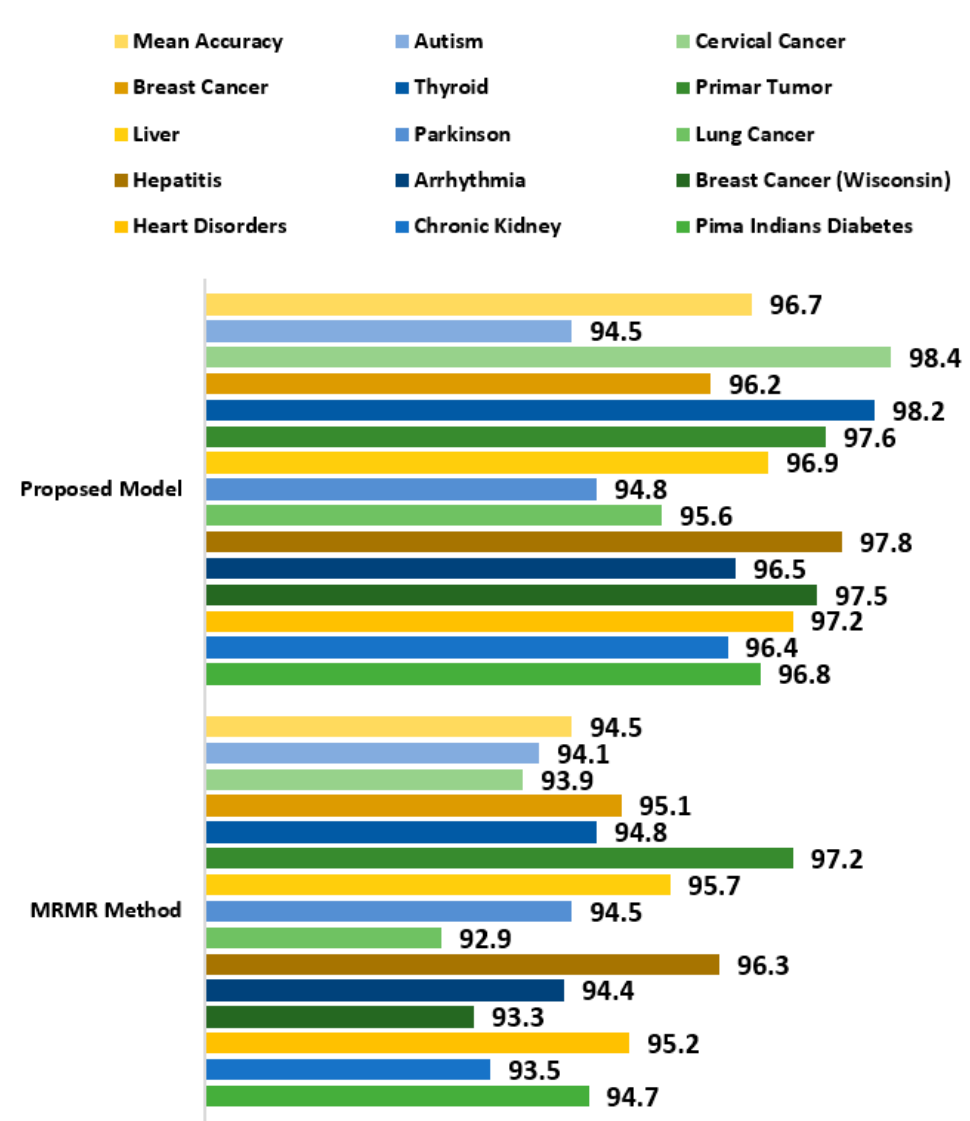
Figure 20. Comparative Study of the Classification Accuracy of the Proposed Attribute Evaluator Method and MRMR method.